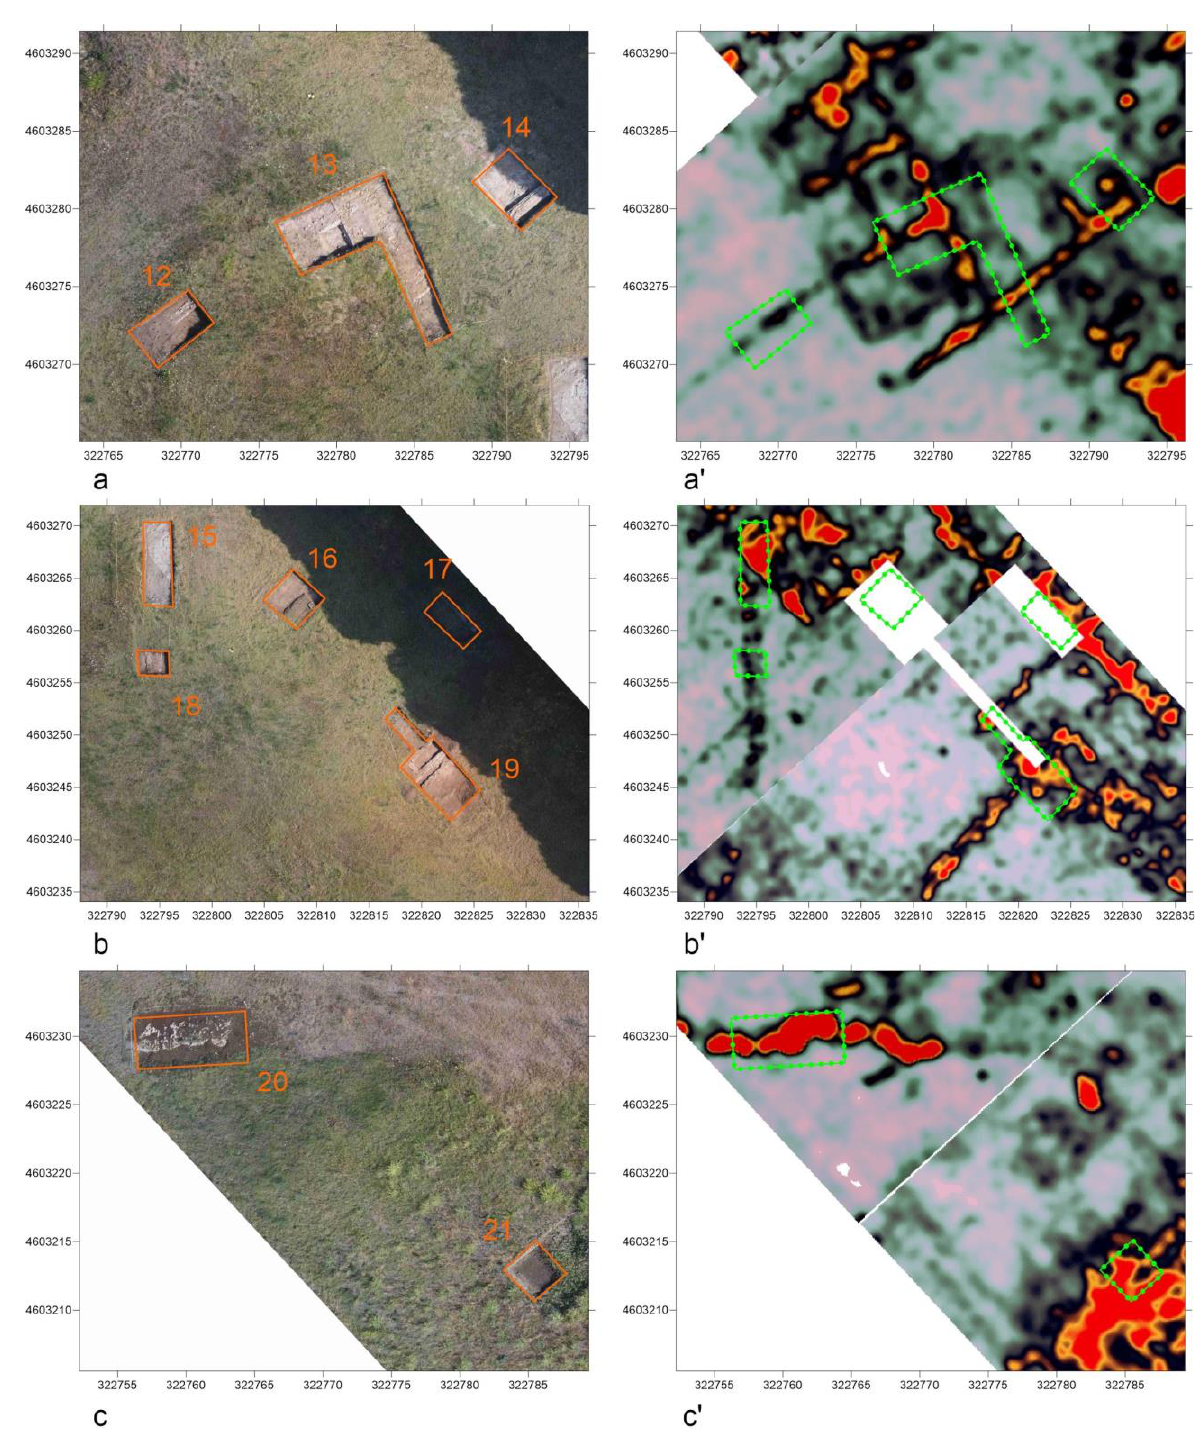
Figure 10. Comparison among ground truth and SE anomalies in the time slices (200 MHz antenna − 0.5/ − 0.7 m). ( a , b , c ) Ground truth; ( a' , b' , c' ) GPR anomalies in the same area. Areas in orange and green correspond to areas traced with GNSS prior to excavation.